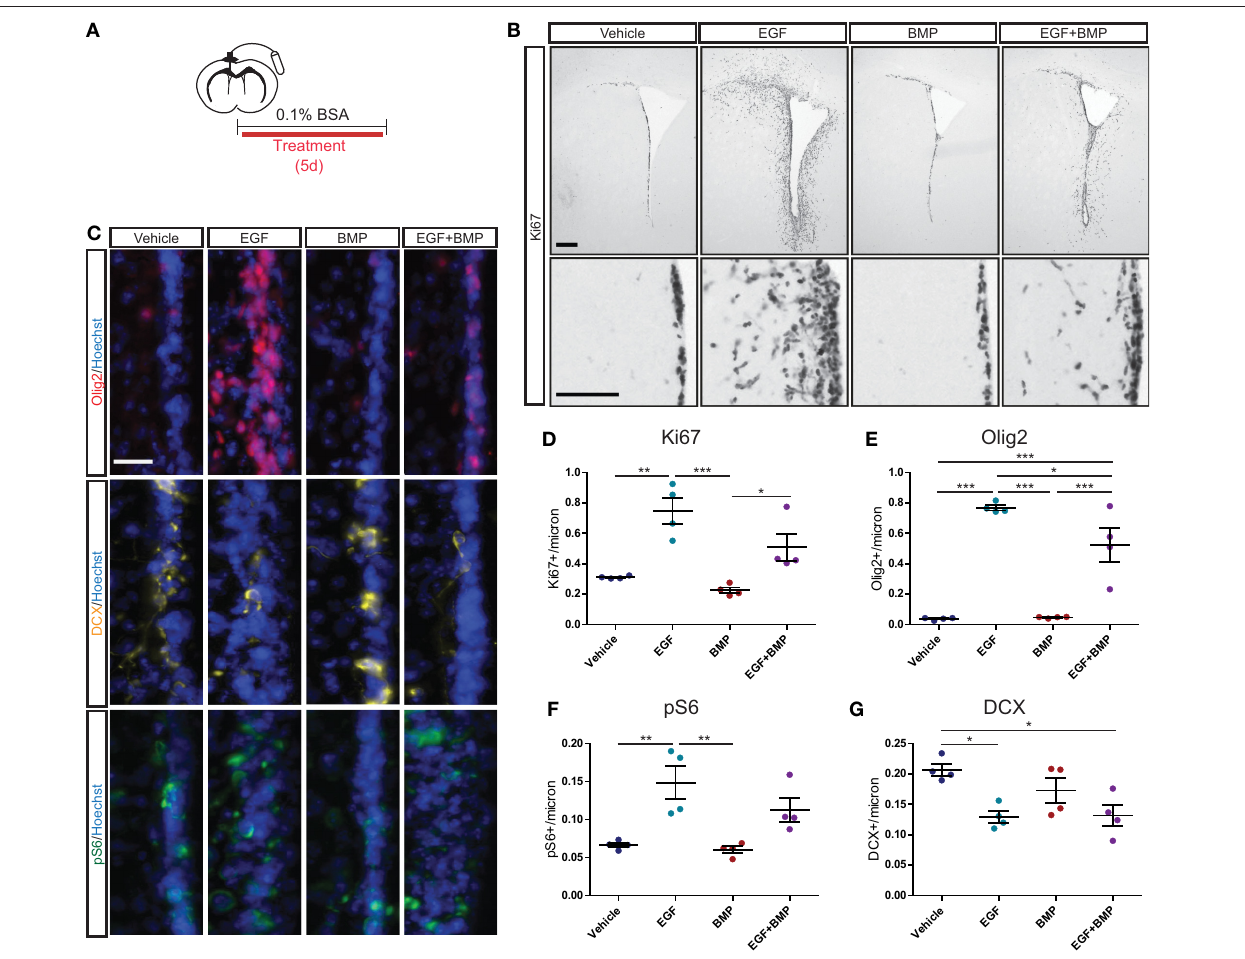
FIGURE 5 | BMP limits EGF-induced expansion of TAPs in vivo . Intracerebroventricular infusion paradigm (see Materials and Methods for details) (A) . Brightfield immunohistochemistry for Ki67, with low magnification (upper) and high magnification (lower) images of each condition (B) . Immunofluorescence for Olig2 (upper), DCX (middle) and pS6 (lower), each counterstained with Hoechst (C) . Quantification of Ki67 + (D) , Olig2 + (E) , pS6 + (F) , and DCX + (G) SVZ cells ( N = 4 /group). Scale bars: (B) top: 250 microns, (B) bottom: 100 microns, (C) : 25 microns. * p < 0.05 , ** p < 0.01 , *** p < 0.001 , One-Way ANOVA (Tukey post-hoc test). Data are represented as mean ±